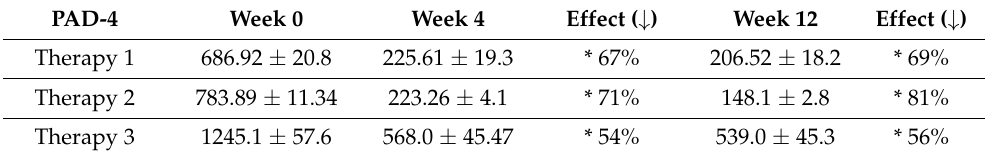
Figure 2. PAD-4 level (pg/mL) before (week 0) and during (week 4, week 12) therapy with: MTX (therapy 1, n = 20), anti-TNF α (therapy 2, n = 20) and anti-IL-17A (therapy 3, n = 10) in patients with plaque psoriasis compared with a control consisting of healthy volunteers ( n = 16). * indicates a statistically significant difference ( p < 0.05) between weeks: 0 and 12. Table 8. PAD-4 level (pg/mL) between treatments: MTX (therapy 1, n = 20), anti-TNF α (therapy 2, n = 20) and anti-IL-17A (therapy 3, n = 10) in patients with plaque psoriasis at three measurement points (week 0, week 4, week 12). * indicates a statistically significant difference ( p <